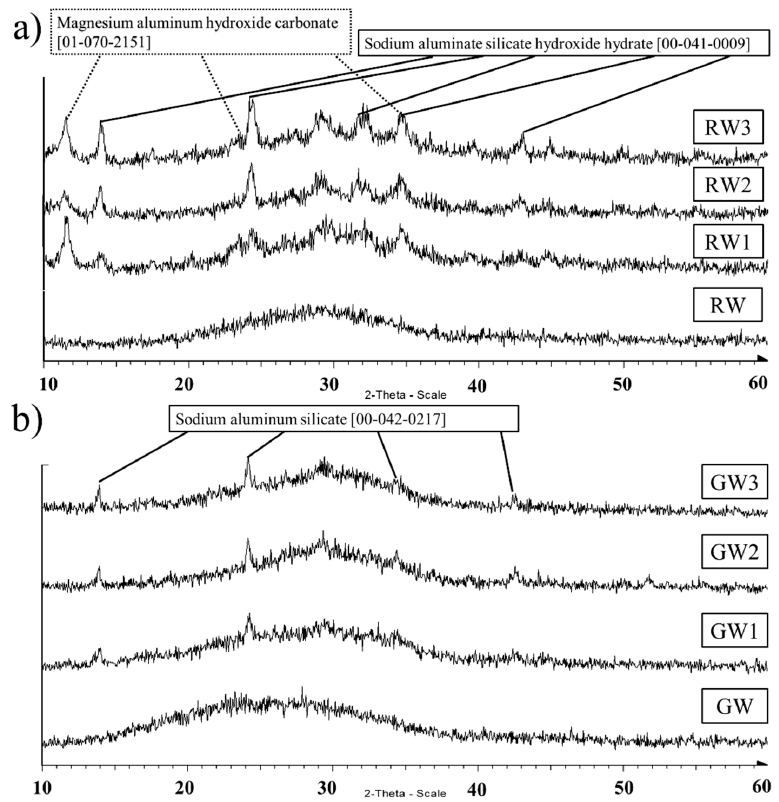
Figure 6. X-ray diffractograms of the ( a ) rock wool (RW); ( b ) glass wool (GW), and the alkali-activated samples.